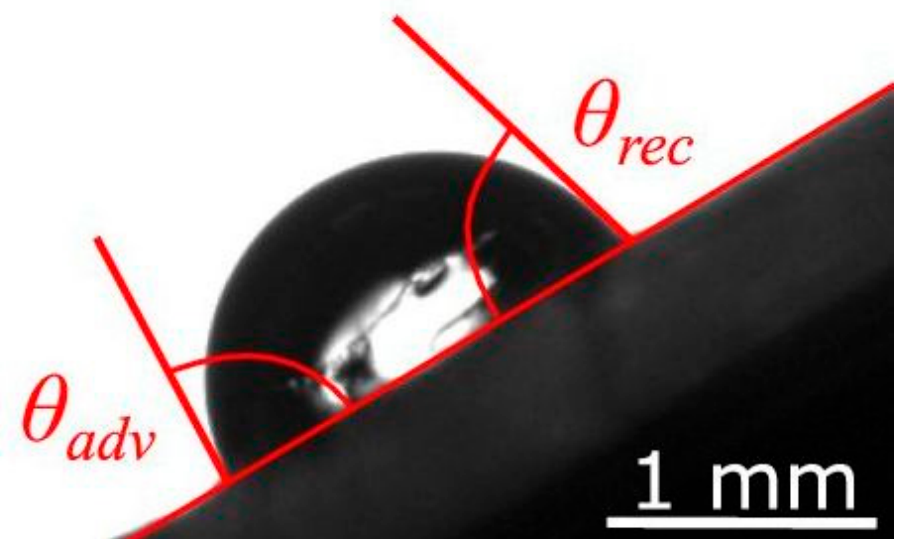
Figure 2. Water droplet placed on the tilted PVC surface is shown. The advancing 𝜃 (cid:3028)(cid:3031)(cid:3049) and reced- ing 𝜃 (cid:3045)(cid:3032)(cid:3030) contacting angles are depicted. The difference ∆𝜃 = 𝜃 (cid:3028)(cid:3031)(cid:3049) − 𝜃 (cid:3045)(cid:3032)(cid:3030) is called the contact angle hysteresis [35–39]. In spite